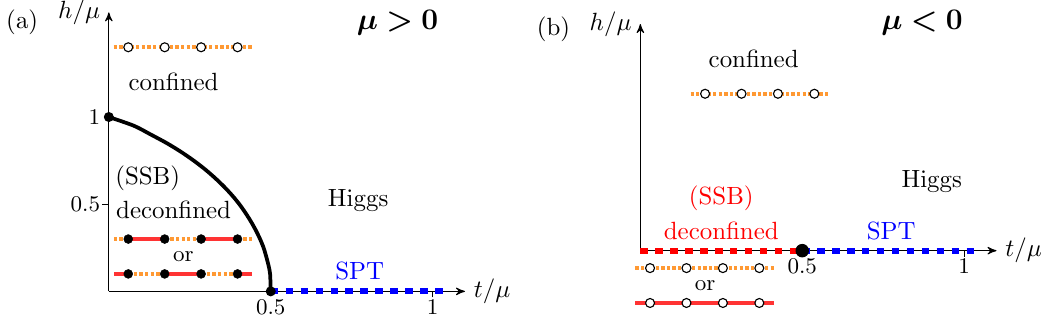
Figure 2: Phase diagram of the gauged Kitaev chain (14) for µ > 0 and µ < 0, respectively. In absence of vortices ( h = 0), the system enjoys magnetic symmetry, protecting an SPT order in the Higgs phase (highlighted by dashed blue line). For h (cid:54) = 0, the Higgs and confined regimes are adiabatically connected. For µ > 0 the solid black line denotes Ising